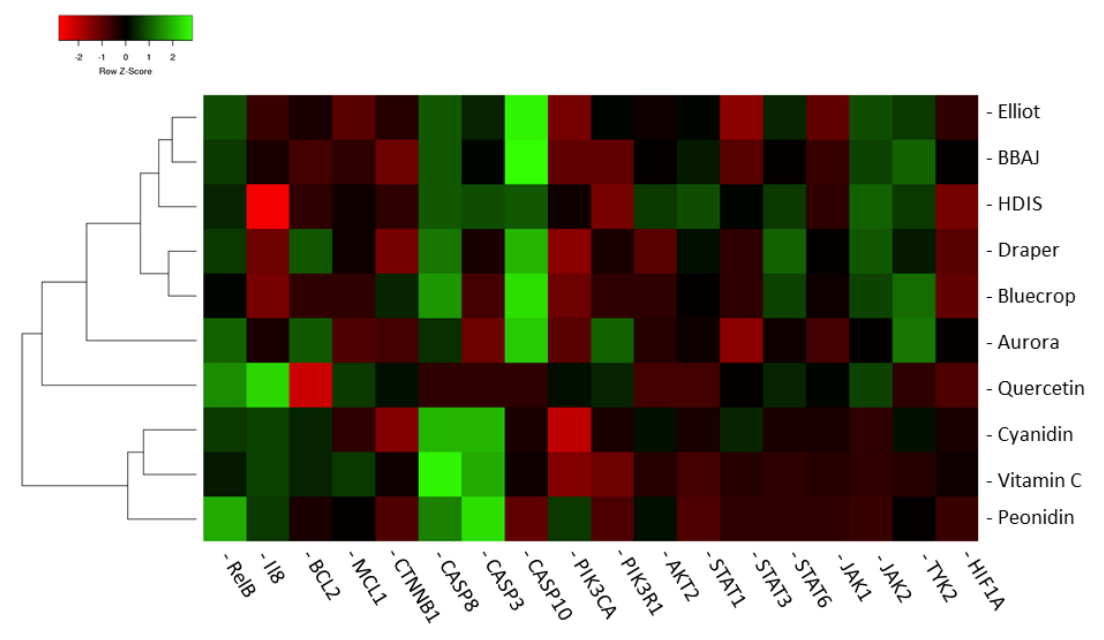
Figure 3. Hierarchical clustering dendrogram of different blueberry extracts (Elliot, Draper, Bluecrop, and Aurora), the extract of the blueberry–apple juice (BBAJ) from the human dietary intervention, and of four single compounds (quercetin, vitamin C, peondin, and cyanidin) based on the effect on the expression of 18 genes selected from a previously conducted human dietary interventions study. In order to compare these gene expression profiles with the profile generated in the human dietary intervention study, the gene expression profile of the human dietary intervention study is included as well (HDIS). Hierarchical clustering analysis was carried out using http://heatmapper.ca. As clustering method complete linkage was used, and distance between the clusters was computed based on Spearman rank correlation. The different conditions are displayed on the y-axis and the genes are shown on the